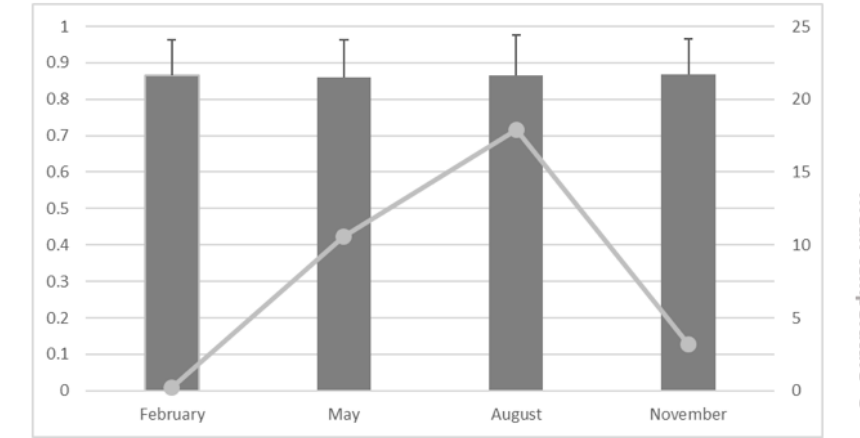
Figure 2. Mean 15D scores (and SD values) and mean temperatures for the study periods.